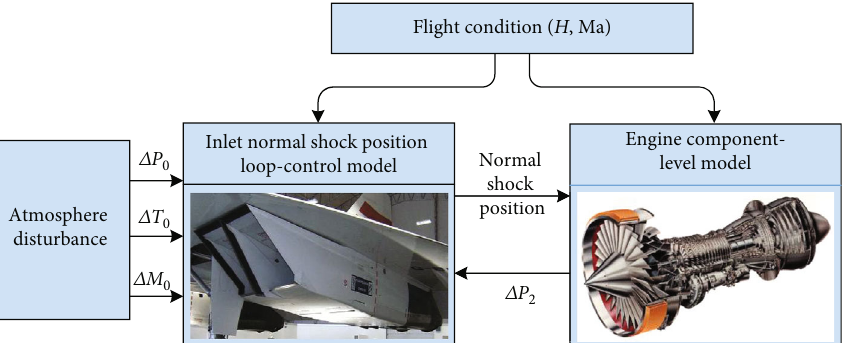
Figure 9: Inlet/engine integrated model calculation.